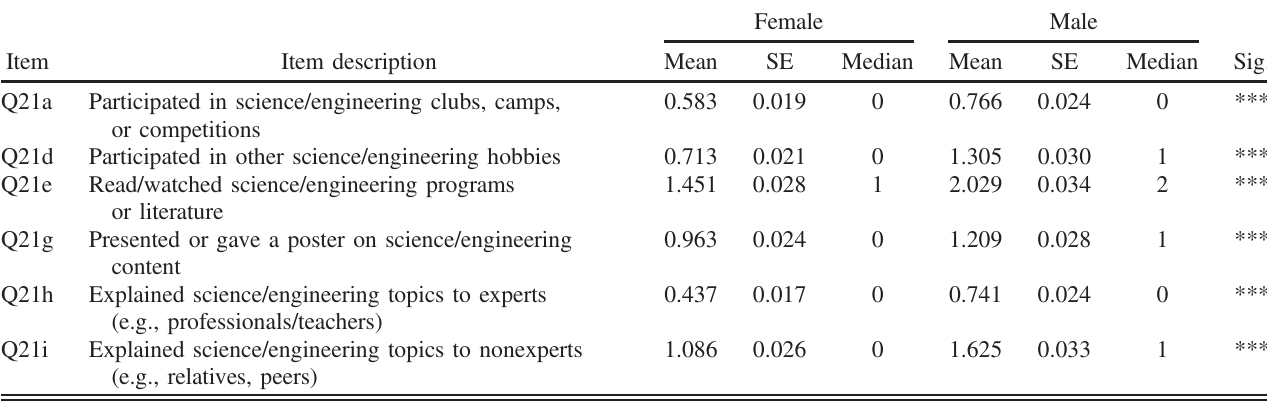
TABLE I. Wilcoxon tests for out-of-class science and engineering activities items.***: p < 0 . 001 .